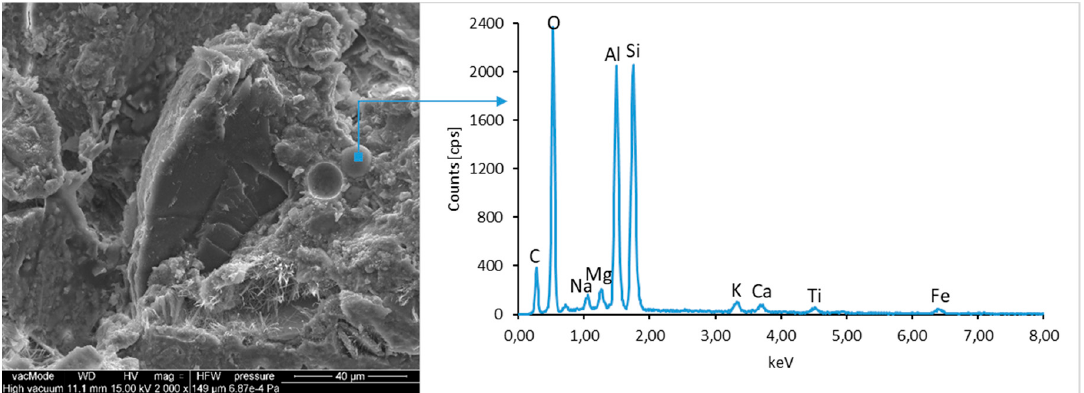
Figure 13. SEM micro-structure of CII.0 concrete and results of elemental analysis in EDS micro-area—well-developed portlandite and C–S–H phase crystals are shown.